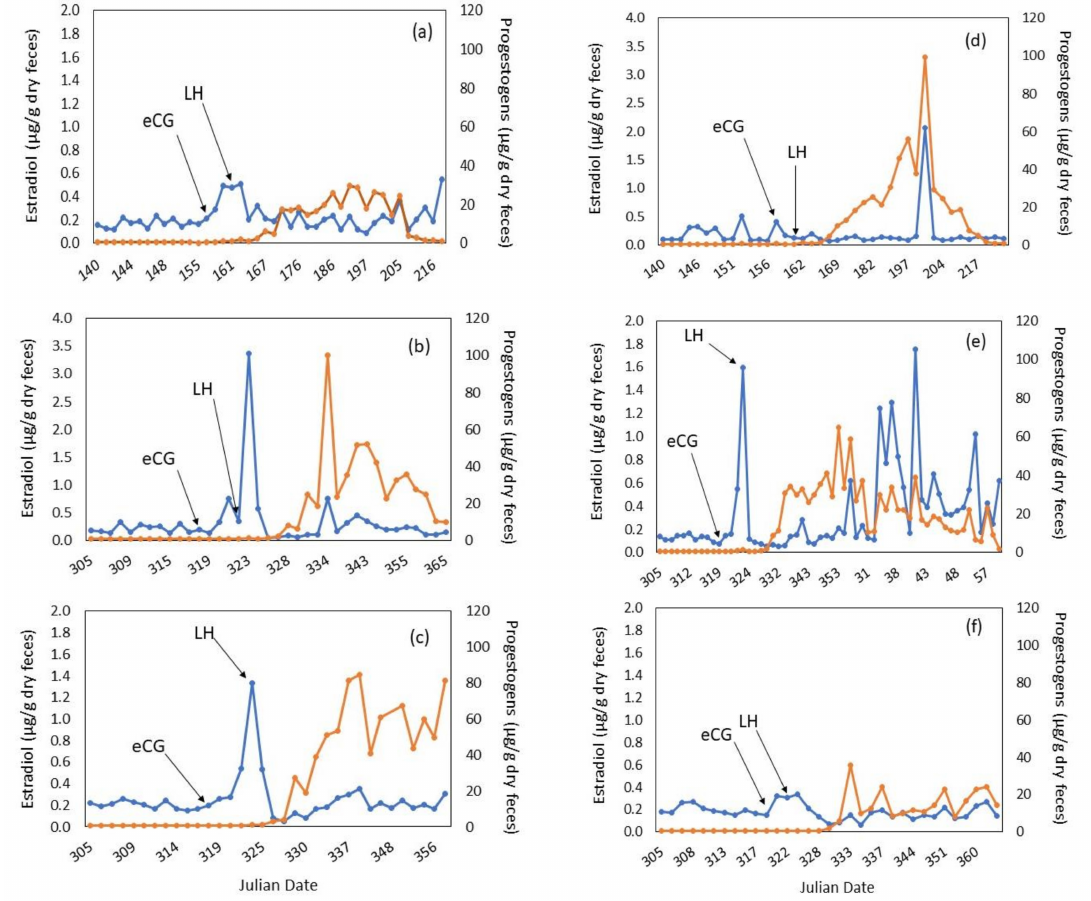
Figure 1. Fecal hormone concentrations for donor ( a – c ) and recipient ( d – f ) cheetah females. Estradiol (blue line) and progestogen (orange line) metabolites are depicted for three oocyte donor cheetahs: ( a ) Donor 1, 7 y old donor at SCBI; ( b ) Donor 2, 9 y old donor at Columbus Zoo; ( c ) Donor 3, 6 y